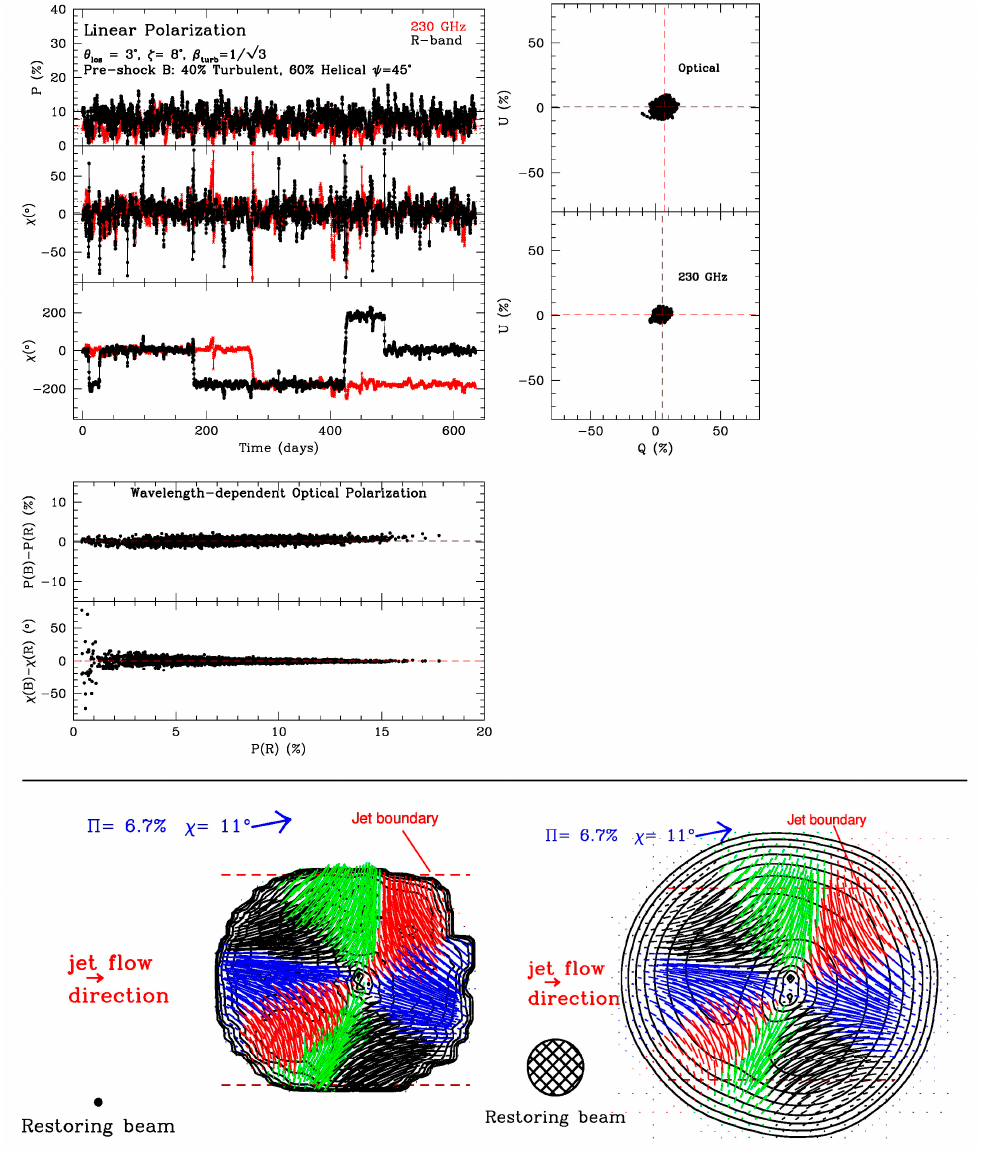
Figure 4. Same as Figure 3, but for the case of the mean magnetic field composed of a 40% turbulent component and 60% helical component with a pitch angle ψ = 45 ° .